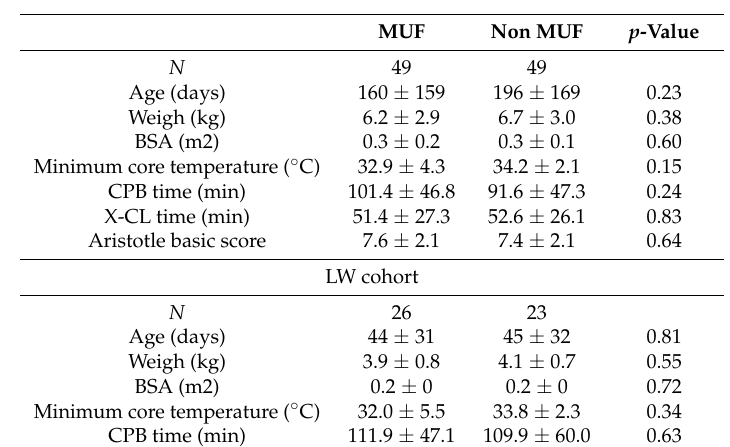
Table 1. Demographics and operative